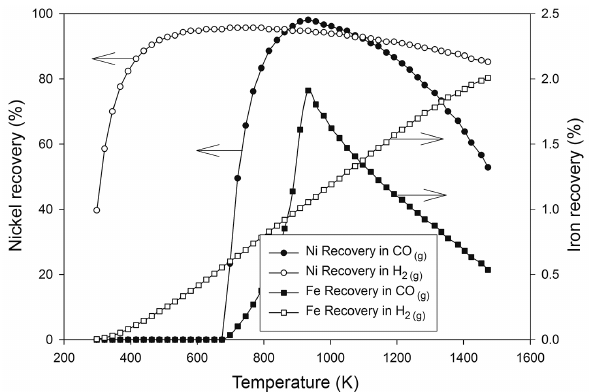
Figure 11: Effect of temperature on the nickel and iron recoveries as a function of temperature for reduction of the ore in pure carbon monoxide or pure hydrogen at a reductant to ore ratio of 0.558 kmol/100